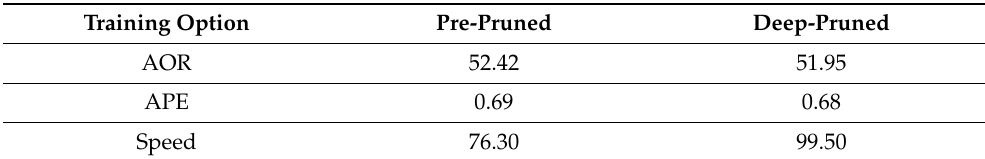
Figure 9. Success and precision plots on OTB2013 dataset with pre-pruned feature network or deep-pruned feature network. Table 2. AOR and APE, as well as speed of pre-pruned feature network or deep-pruned feature network, on the OTB2013 dataset.